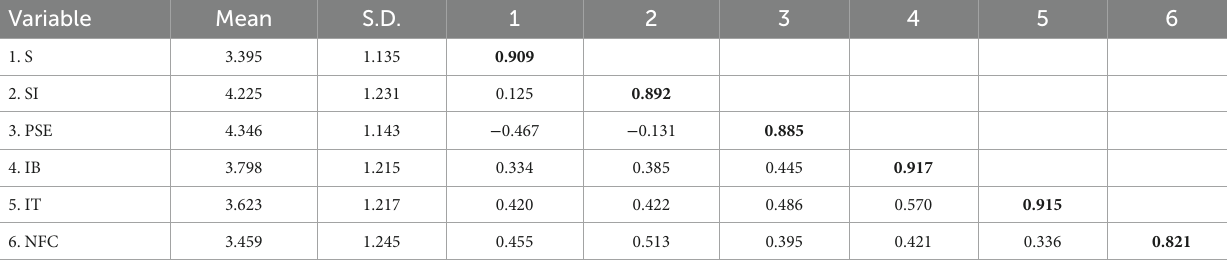
TABLE 3 Means, standard deviations, and correlations.